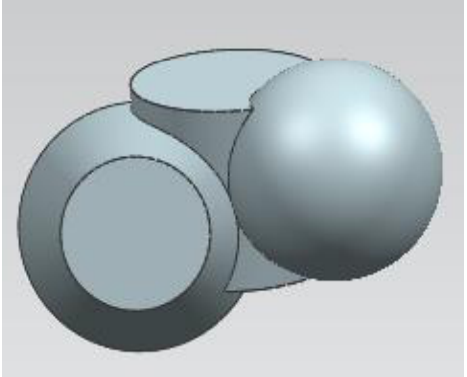
Figure 1. Sketch of a 3D model drafted by the CAD